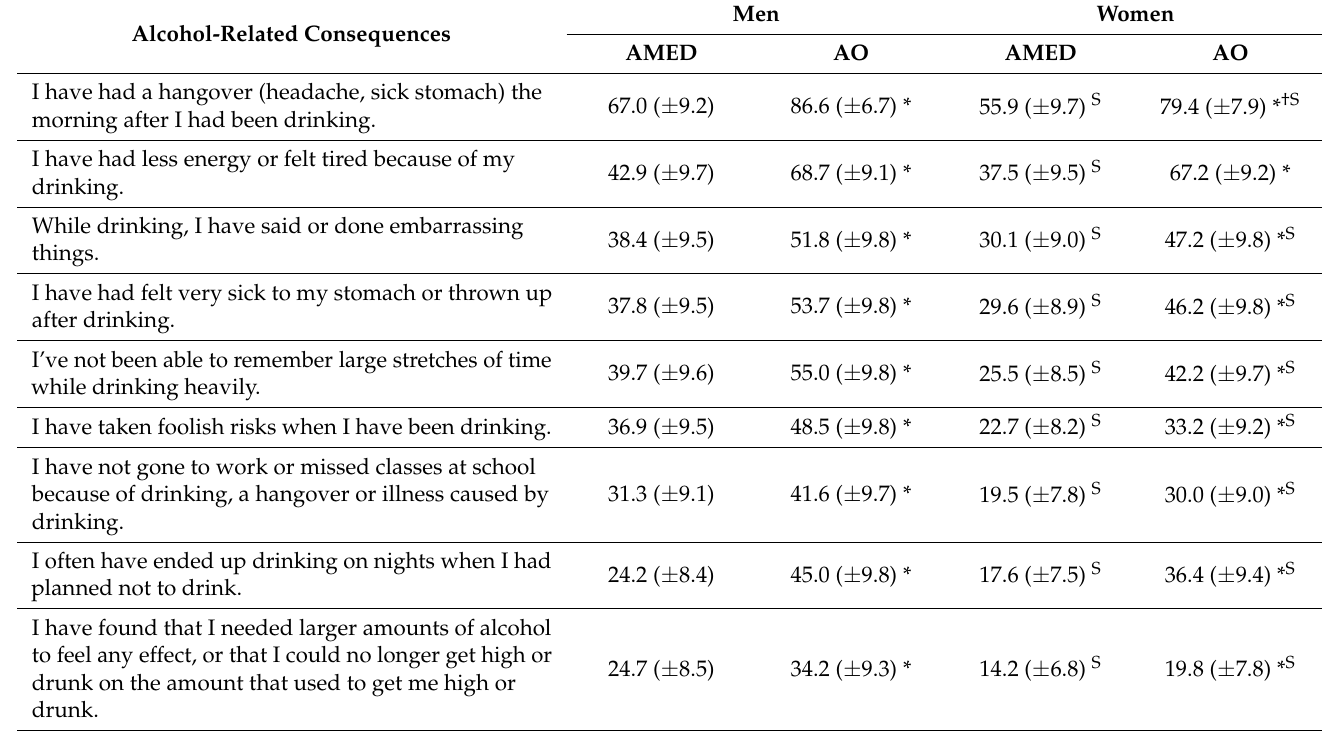
Table 11. Alcohol-related consequences reported by men and